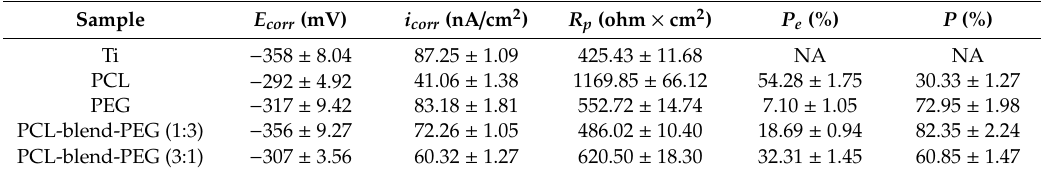
Table 2. Main electrochemical parameters of the electrochemical process (the data are presented as mean ± SD).